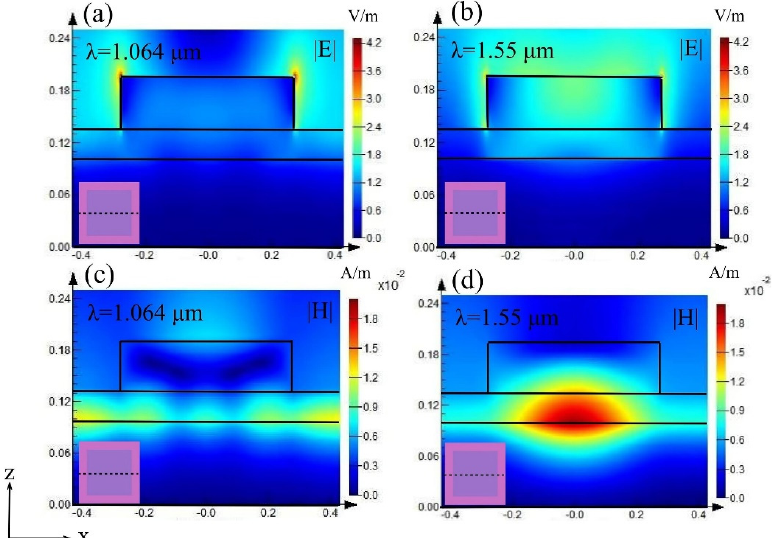
Figure 3. Cross-sectional view of the electromagnetic field distributions. ( a , c ) Electric and magnetic field distributions at the wavelength of 1.064 μ m, respectively. ( b , d ) Electric and magnetic field dis- tributions at the wavelength of 1.55 μ m, respectively. Insets show the location of the cross-section. Then, the permittivity, permeability, effective refractive index and effective imped- ance of the metasurface were retrieved [28], as shown in Figure 4. In Figure 4a,c, it can be seen that Im( ε ) and Im( μ ) are positive and large at wavelengths of 1.064 μ m and 1.55 μ m, indicating magnetic resonance. Meanwhile, Im( ε ) is positive and large at the two wavelengths, indicating high loss. According to = Z λ μλ ε λ （ ） （ ）（ ） , we can obtain the ef- fective impedance of the metasurface, as shown in Figure 4d. For the wavelength of 1.064 μ m, Re( Z ) is relatively large and close to 1, and Im( Z ) is approximately 0. For the wave- length of 1.55 μ m, Re( Z ) is close to 1, and Im( Z ) is a relative maximum. These indicate that the impedance of the metasurface is matched to the free space at wavelengths of 1.064 μ m and 1.55 μ m, resulting in reduced reflections. Therefore, at 1.064 μ m and 1.55 μ m wavelengths, the loss increases and the reflection decreases, leading to an increase in ab- sorption. However, since Z does not reach 1, there will be little reflection, and the ab- sorption does not reach 100%.